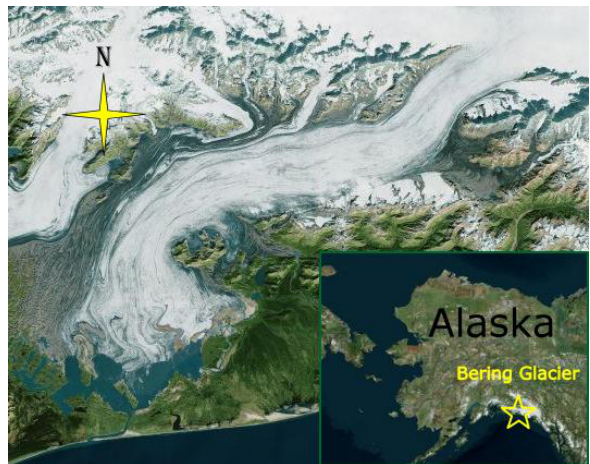
Figure 1 . Bing satellite image of the Bering Glacier terminus. A portion of 28 Fig. 1. Bing satellite image of the Bering Glacier terminus. A por- the Bagley Ice Field is shown at the top of the image. 29 tion of the Bagley Ice Field is shown at the top of the image.